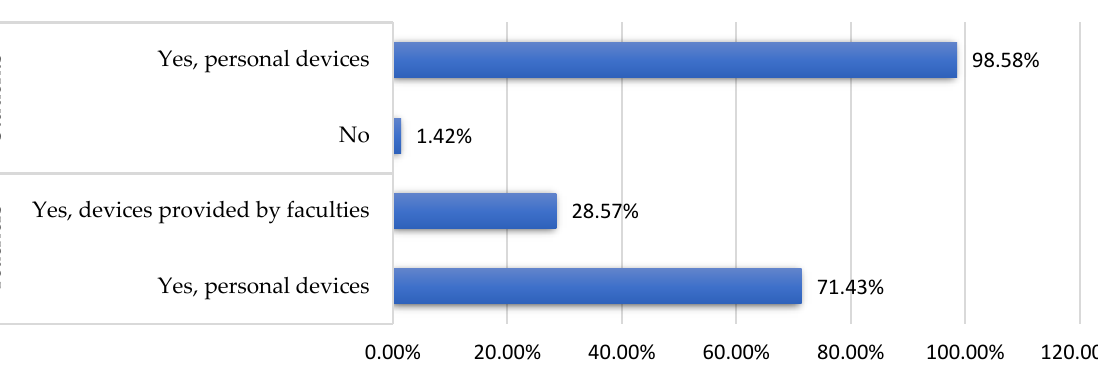
Figure 2. Computers owned by students and teachers to participate in online education.